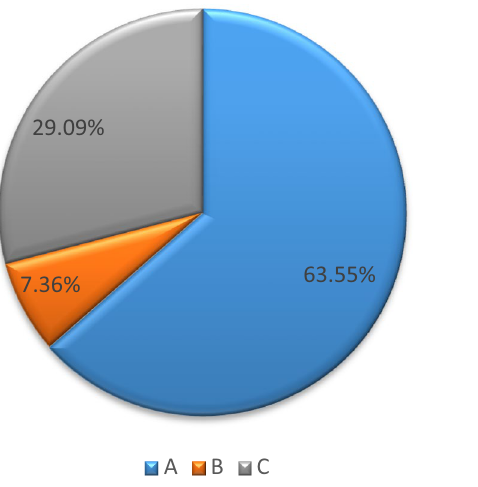
Figure 2. East Java farmer